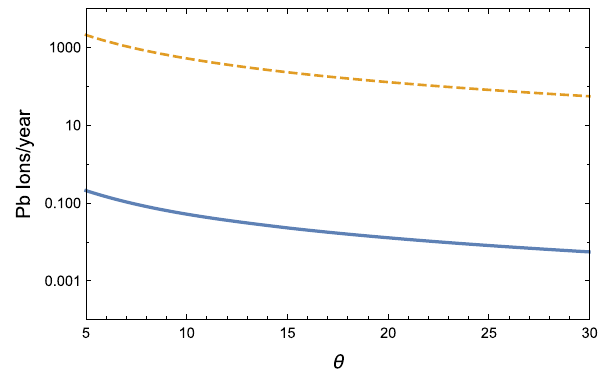
Fig. 7 The figure shows the number of ions scattered by a monopole– anti-monopole pair for a 2 . 76 TeV/nucleon 208 Pb 82 + beam, with d = 240 fm , β = 0 . 01 and luminosity 10 27 cm − 2 s − 1 (solid) and with β